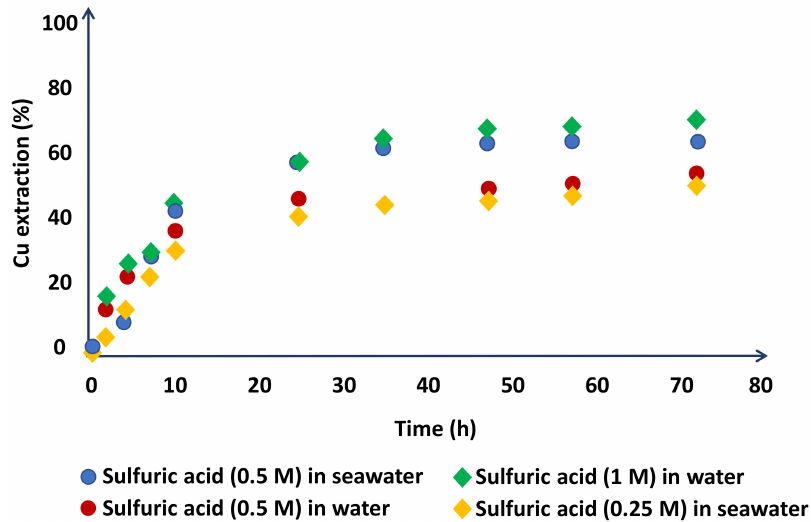
Figure 4. Chalcopyrite dissolution in the leach liquors with experimental conditions of NaNO 3 (1 M), three days of leaching, 45 °C (Modified from [46]).